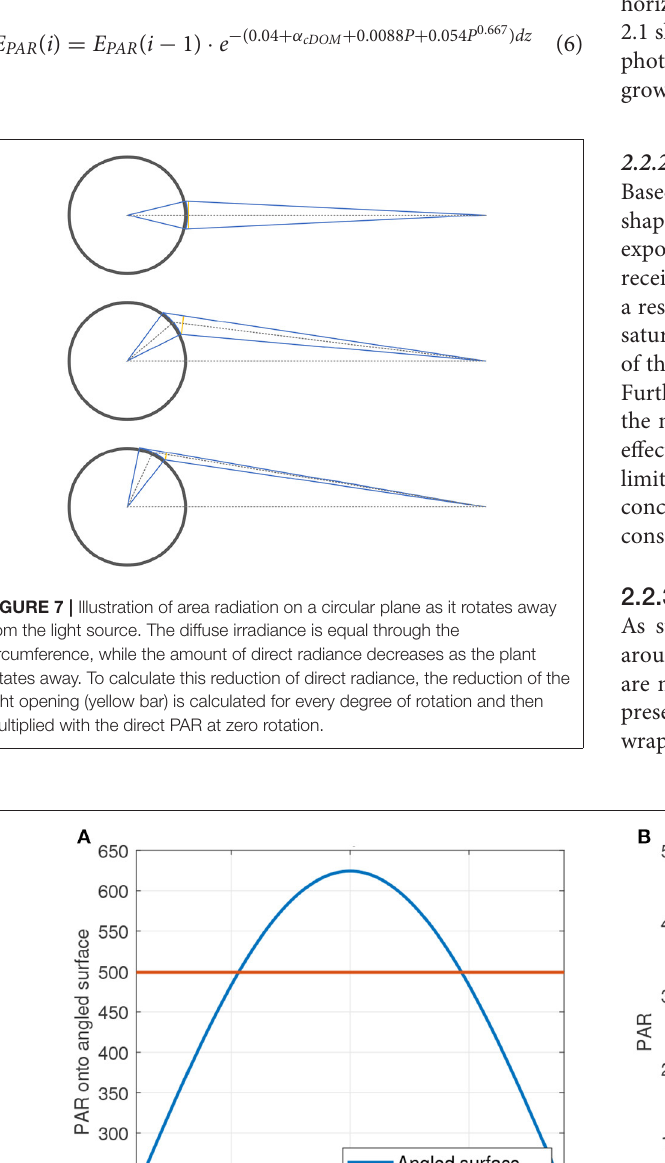
Frontiers in Marine Science |